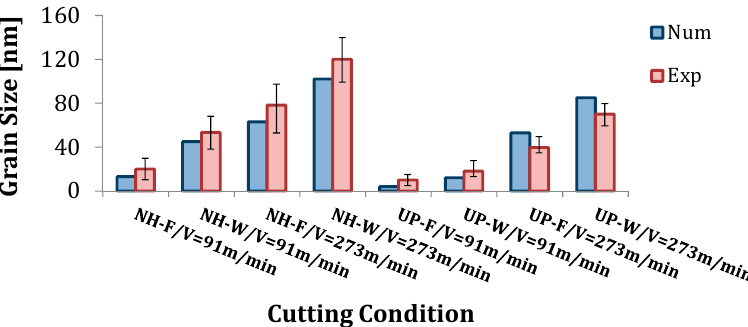
6 of 12 Figure 3. Grain size prediction: positive rake fresh insert with cutting speed (UP-F/V) = 273 m/min.